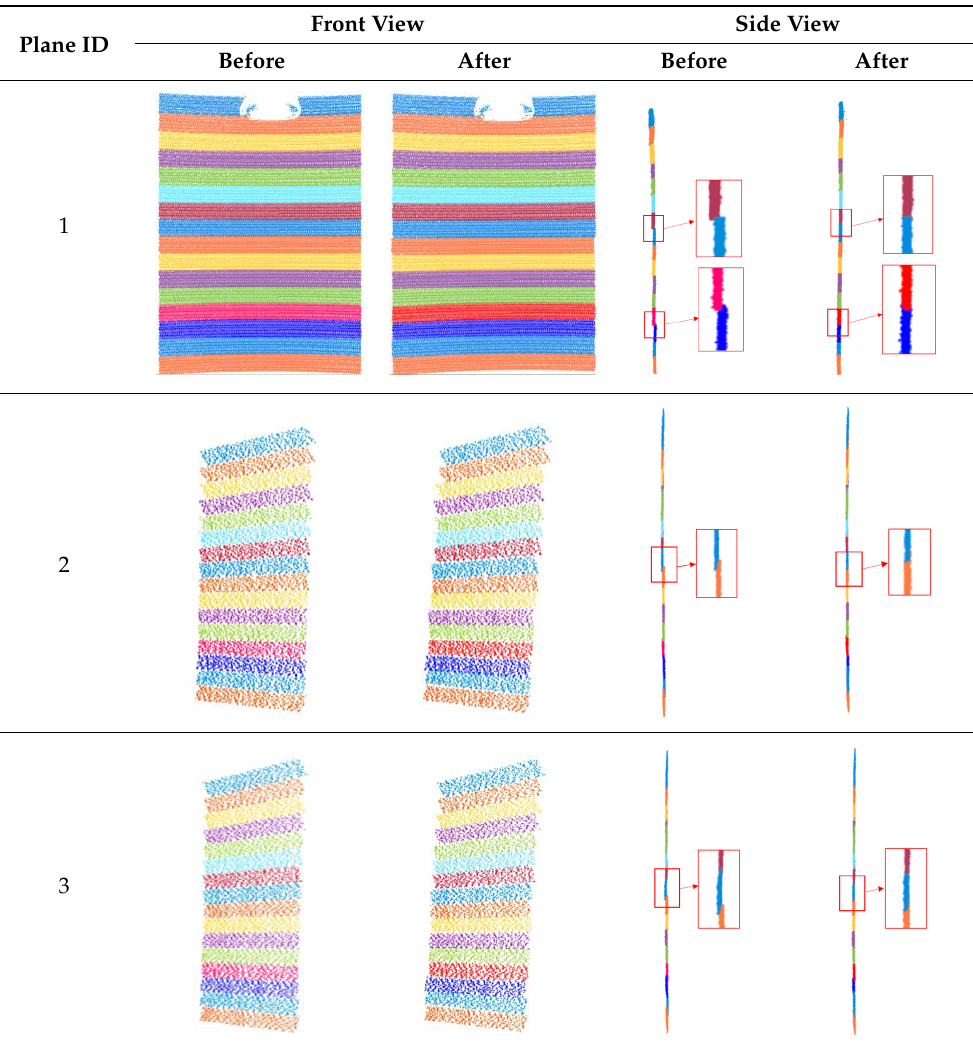
Table 3. Comparison of the point clouds before and after the calibration.